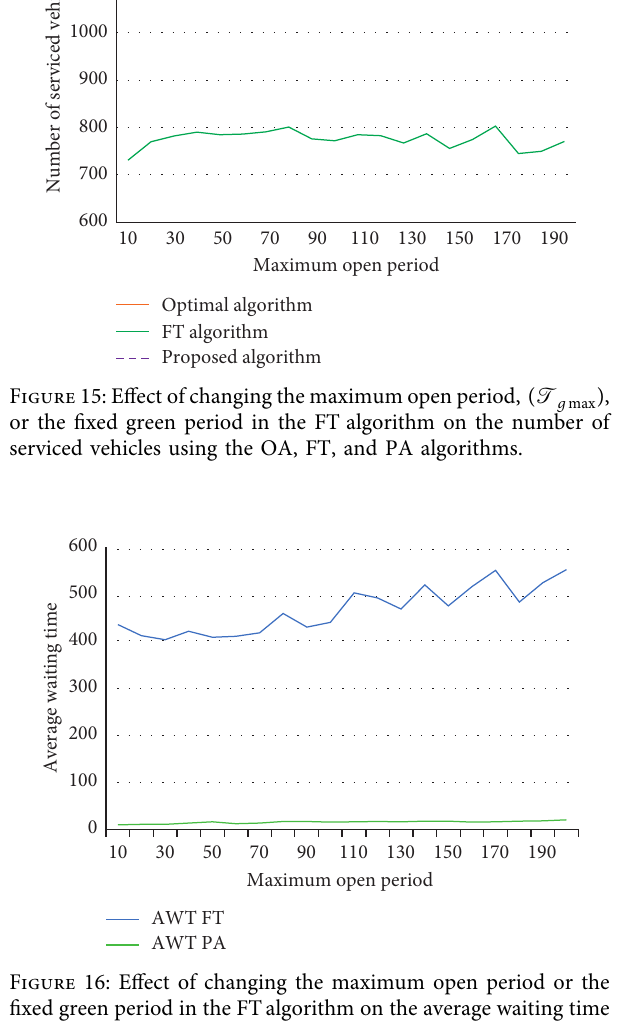
Figure 16: Effect of changing the maximum open period or the fixed green period in the FTalgorithm on the average waiting time (AWT) using the FT and PA